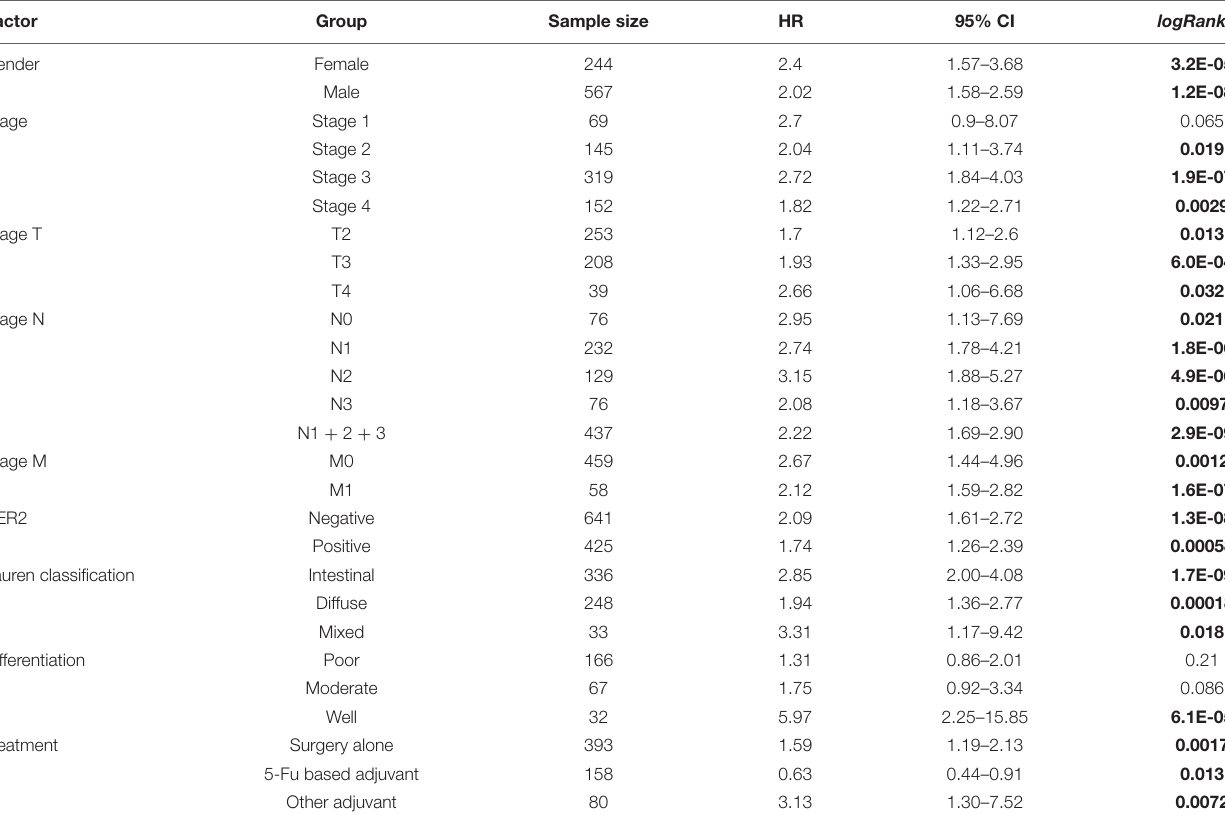
TABLE 1 | Correlation of ISLR expression and the overall survival of gastric cancer patients in the GEO cohort (Kaplan – Meier plotter). Factor Group Sample size HR 95% CI logRank_P